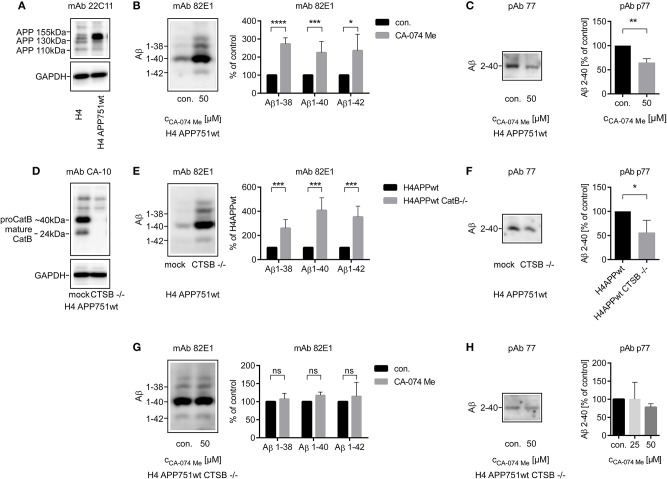
Stable transfection of APP751 in H4 cells was controlled by SOS-PAGE followed by immunoblot probed with anti-APP mAb 22C11 (A). Four milliliters (B,E,G) or 10 ml (C,F,H) of conditioned media from H4 APP751wt cells were used for the analysis of secreted Aβ peptides. The relative abundance of Aβ 1-x (B) was increased after the stimulation with CA-074 Me over 48 h in supernatants of H4 APP751wt cells as assessed by 1D Urea-SDS-PAGE followed by immunoblot, whereas the amount of Aβ co-migrating with Aβ 2-40 was decreased compared to controls (C). Deletion of CTSB via CRISPR/Cas9 technology was controlled by SOS-PAGE followed by immunoblot probed with anti-CatB mAb CA-10 (D). The abundance of Aβ 1-x was increased in H4 APP751wt CTSB –/– cells compared to H4 APP751wt cells (E), whereas Aβ co-migrating with Aβ 2-40 was slightly decreased (F). In H4 APP751wt CTSB –/– cells, treatment with CA-074 Me did not significantly alter the abundance of Aβ co-migrating with synthetic Aβ 1-38, Aβ 1-40 or Aβ 1-42 (G), but it slightly reduced the amount of Aβ 2-x (H). Statistics: (B) ratio paired T-Test Aβ 1-38, t(4) = 18.04, p < 0.001, (F)
n = 4, ratio paired T-Test t(3) = 3.435, p < 0.05 (G)
n = 3, ratio paired T-Test Aβ 1-38, t(2) = 0.3416, p > 0.05, ratio paired T-Test Aβ 1-40, t(2) = 3.857, p > 0.05, ratio paired T-Test Aβ 1-42, t(2) = 2.776, p > 0.05 (H)
n = 3, Kruskal-Wallis test H (2) = 3.310, p > 005. Selected comparisons are indicated as follows *p < 0.05; **p < 0.01; ***p < 0.001; and ***p < 0.0001.